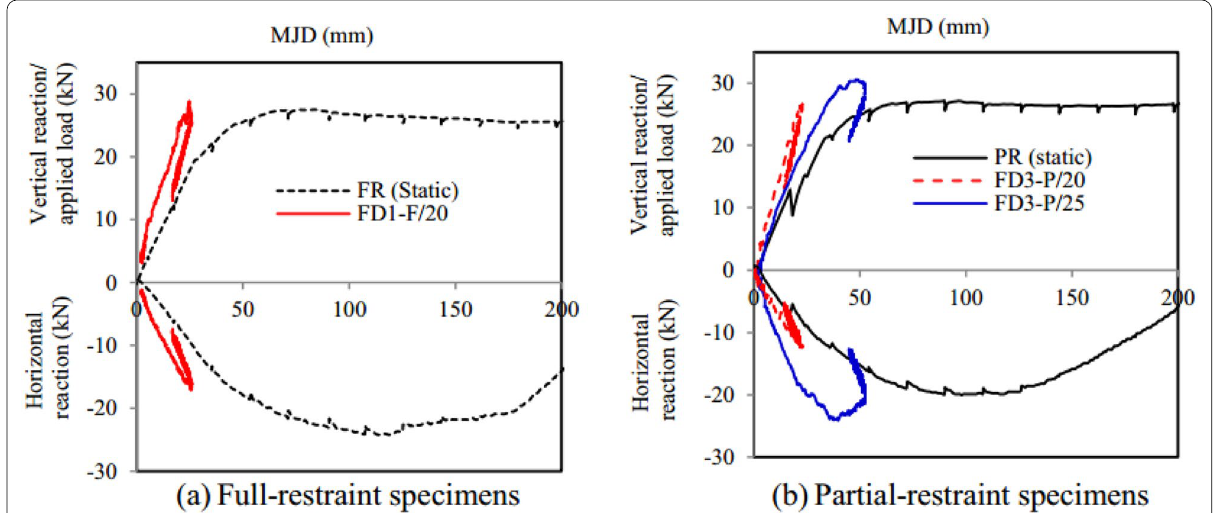
Fig. 7 MJD–reaction relationship in CAA stage. Image by courtesy of Pham (Nanyang Technological